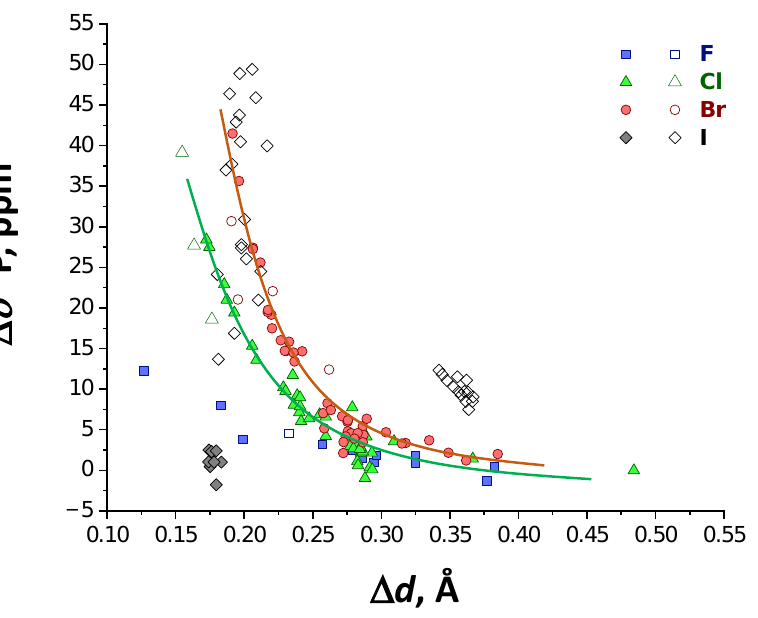
Figure 7. The correlation of ∆ δ 31 P on ∆ d for a series of R–X · · · OPMe 3 complexes. The solid lines are guides for the eye added for Cl- and Br-bonded complexes.